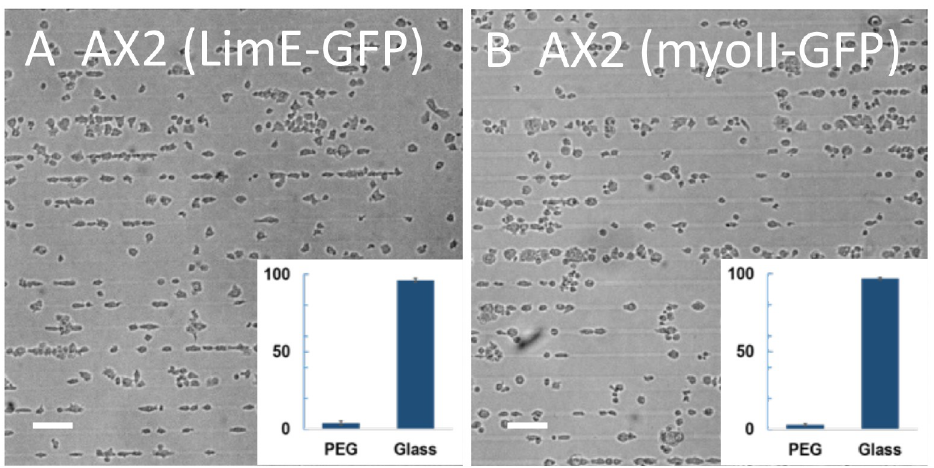
Fig 5. Developed AX2 cells with fluorescent markers on micropatterned substrates. Micrographs of developed AX2 cells expressing LimE-GFP (A) and myoII-GFP (B) on the micropatterned substrate taken 10 min after plating. Insets: relative coverage of cells on PEG-gel and glass stripes. (Scale bar: 50 μm